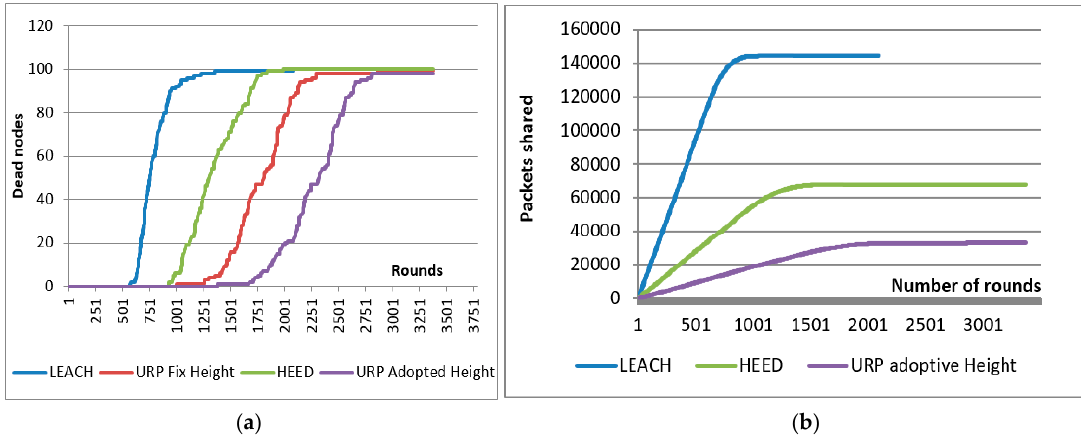
Figure 12. Comparison of existing routing protocols with the proposed system ( a ) Number of rounds vs. dead nodes; ( b ) comparison of the amount of inter-cluster communication in different routing algorithms that is required to formulate a cluster.